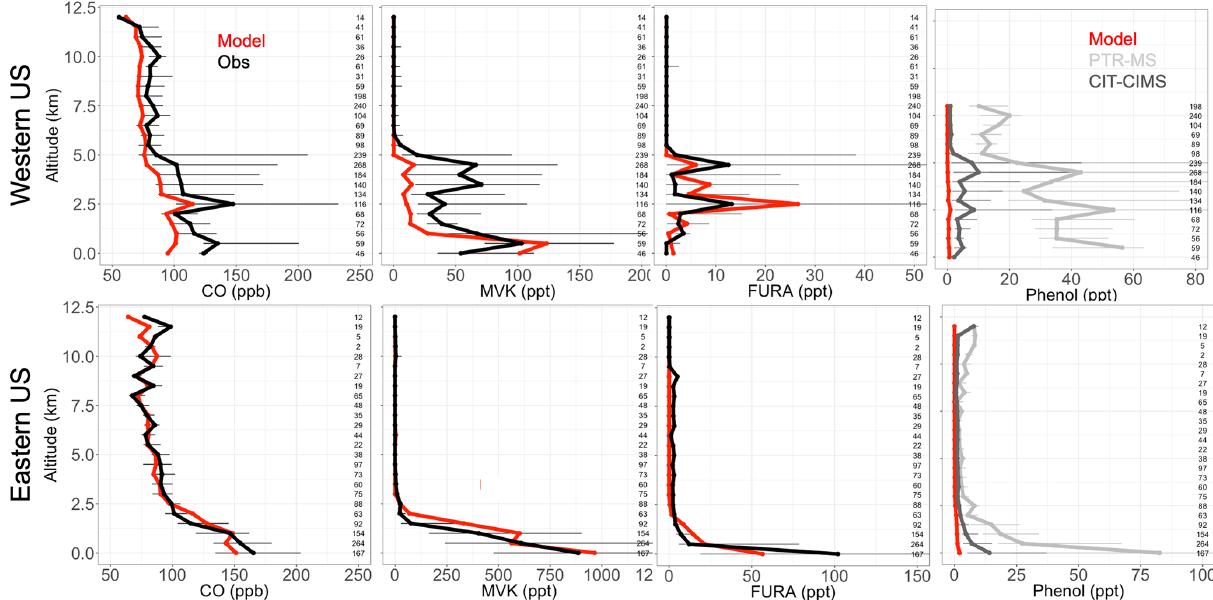
Figure 3. Binned observed (black) and simulated (red) median vertical profiles of CO, MVK, lumped furan species (FURA = furan + 2- methylfuran + 2,5-dimethylfuran), and phenol concentrations from the FIREX-AQ campaign. For phenol, observations using the PTR-MS are in light grey and those from the CIT-CIMS in dark grey. Horizontal bars show the 25th–75th percentile range of measurements in each vertical 0.5km bin. The number of observations in each bin is shown on the right side of each panel.